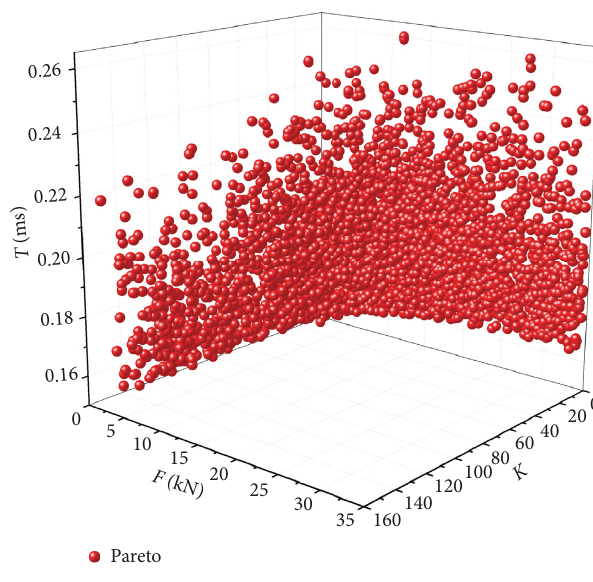
Figure 9: 3D Pareto-optimal solutions.